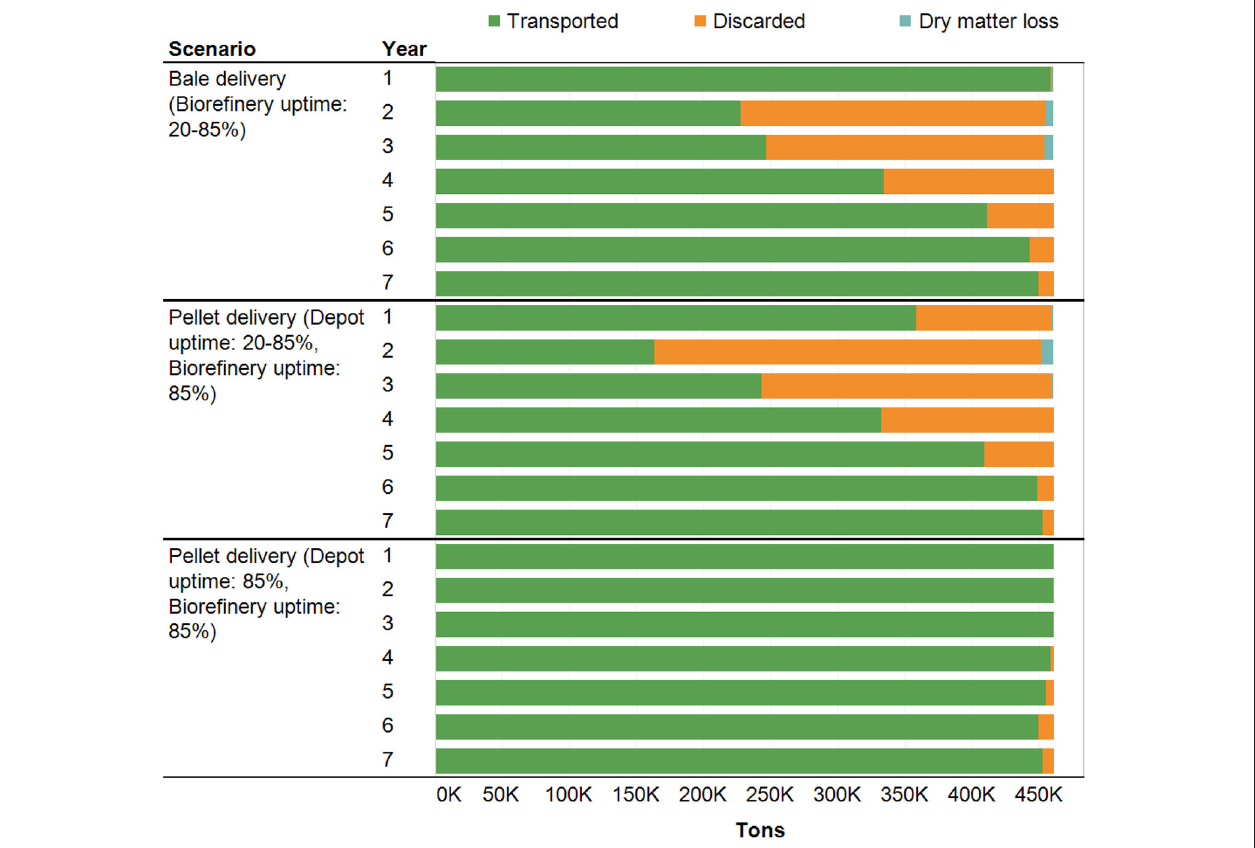
FIGURE 6 | Farm metrics for the bale-delivery (Biorefinery uptime: 20–85%), pellet-delivery (Depot uptime: 20–85%, Biorefinery uptime: 85%) and pellet-delivery (Depot uptime: 85%, Biorefinery uptime: 85%) scenarios.